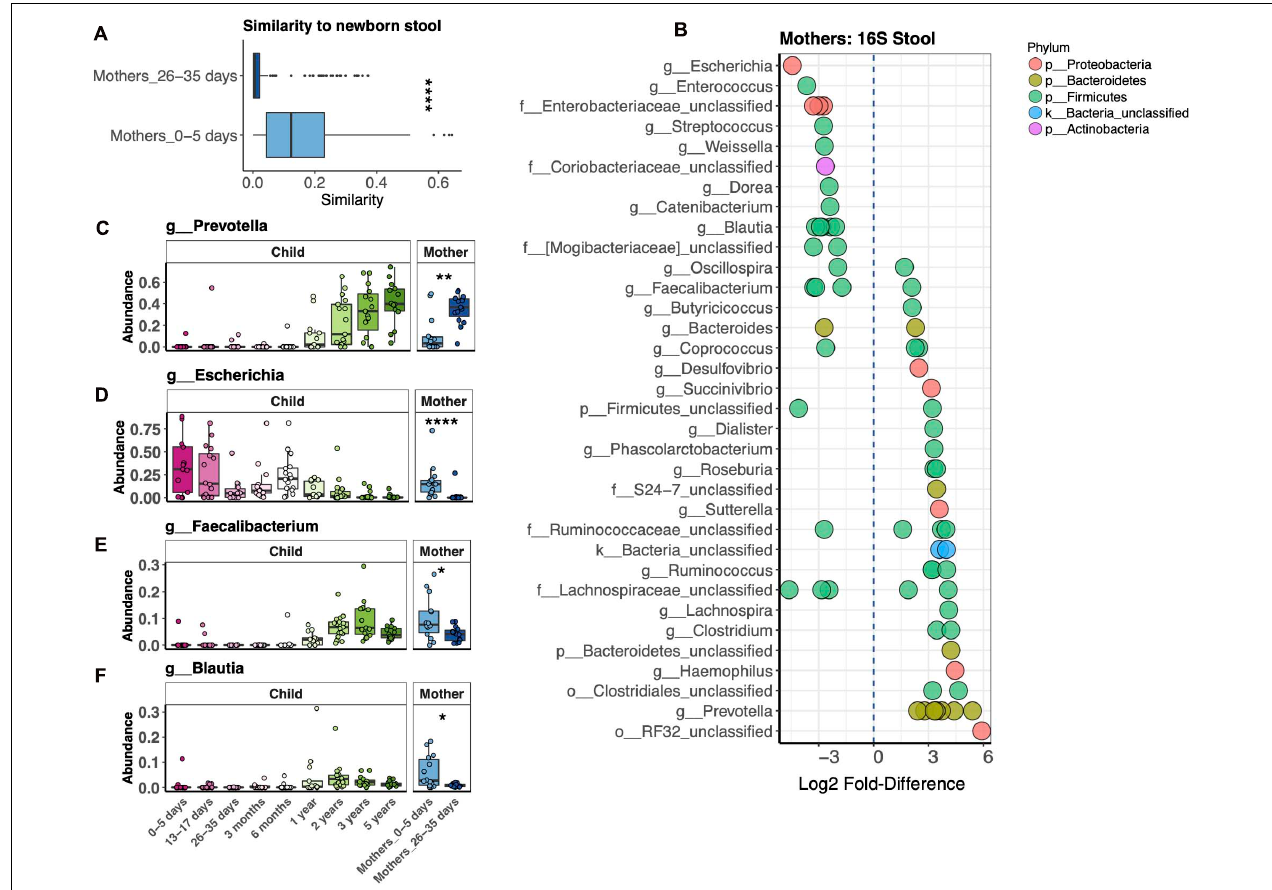
FIGURE 4 | Comparison of fecal bacterial microbiotas of mothers 1 and 4 weeks postpartum and children at 1 week. (A) Average pairwise similarity of the microbiotas of mothers vs. those of their children. (B) Operational taxonomic units (OTUs) identified by DESeq2 differentially abundant between mothers 1 week vs. 4 weeks postpartum. Negative fold-difference indicates greater abundance 1 week postpartum. (C–F) Relative abundance of selected taxa that were differentially abundant between mothers 1 week vs. 4 weeks postpartum. **** p < 0.0001, ** p < 0.01, * p < 0.05, Wilcoxon rank-sum test, adjusted using the Bonferroni